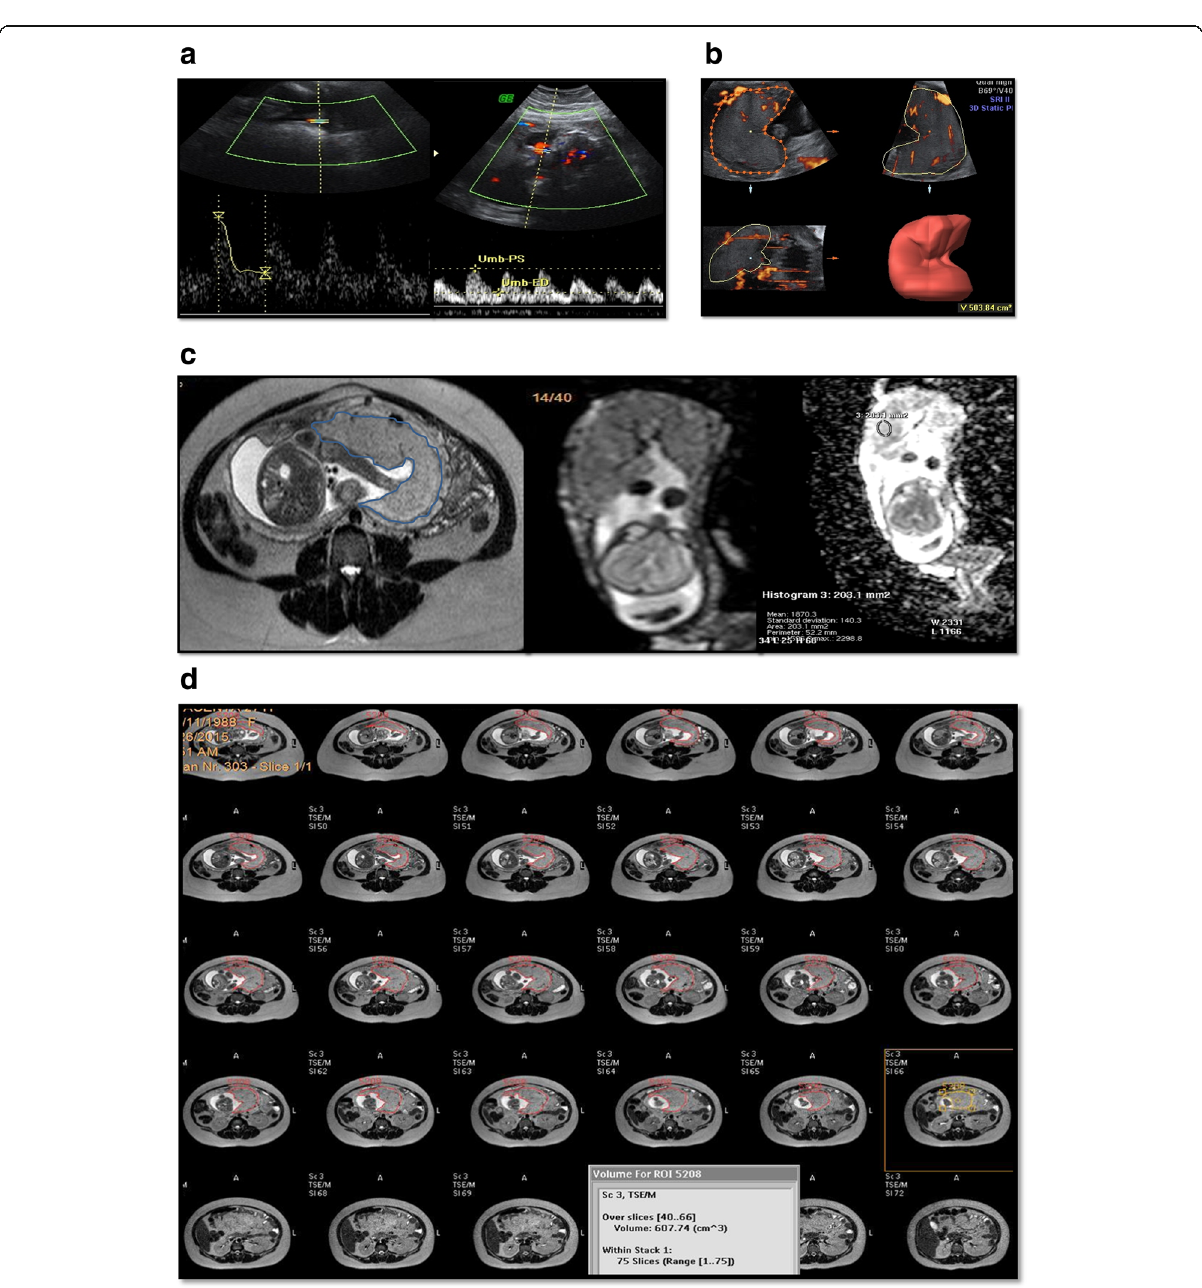
Fig. 3 Pregnant female, 27 years old. The patient has hypertension with pregnancy on Aldomet. No history of preeclampsia. Her obstetric code was G4P1 + 2. Gestational age: 25 weeks+ 5 days. a Doppler examination of both uterine and umbilical arteries showed normal RI of the examined arteries, a normal wave of the uterine artery, and no notch. b Placental volume measurement by 3D ultrasound (503.84 cm 3 ). c From right to left, (i) axial T2-weighted image, (ii) sagittal DWI at b 850, and (iii) ADC map that showed average placenta thickness and normal homogenous pattern. ADC value equals 1.87 × 10 – 3 mm 2 /s. d Placental volume measurement by MRI (607.74 cm 3 ). Comments: The patient had gestational hypertension but 3D ultrasound and MR showed features of a normal placenta. MRI was more accurate in the assessment of the placental volume. She had a cesarean section with normal averaged weight